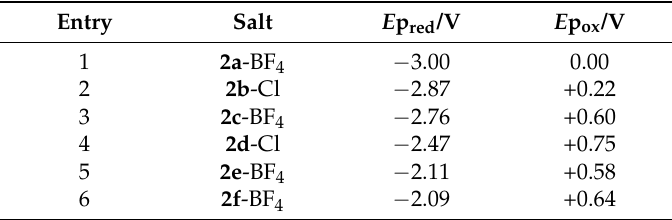
Table 3. Cyclic voltammetries of 2a – f (0.10 M) in DMF (Figure 7). Reduction and oxidation peak